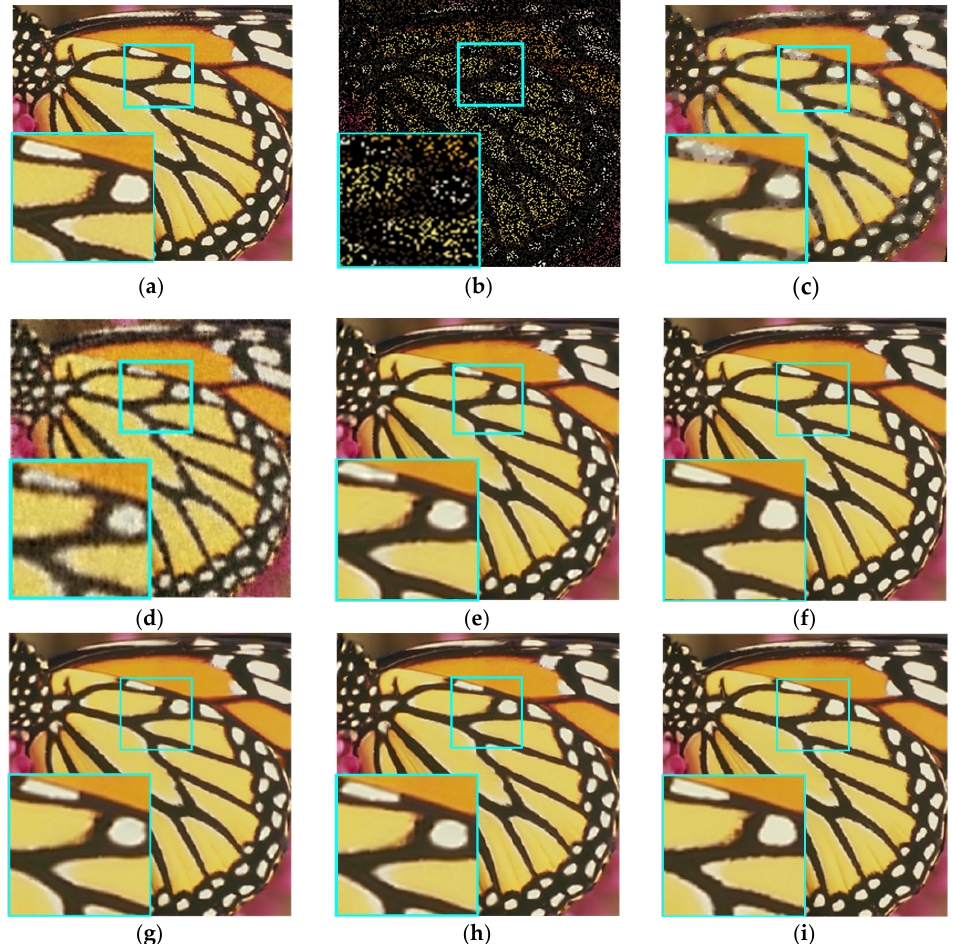
Figure 3. The restoration results of butterfly with pixel missing rate of 80%. ( a ) Butterfly, ( b ) butterfly with pixels missing rate 80%, ( c ) SALSA [38] (PSNR = 22.85), ( d ) BPFA [4] (PSNR = 21.06), ( e ) GSR [13] (PSNR = 26.03), ( f ) MAR-LOW [41] (PSNR = 30.86), ( g ) JPG-SR [14] (PSNR = 26.58), ( h ) GSRC-NLP [27] (PSNR = 26.78), ( i ) our model (PSNR = 30.90).